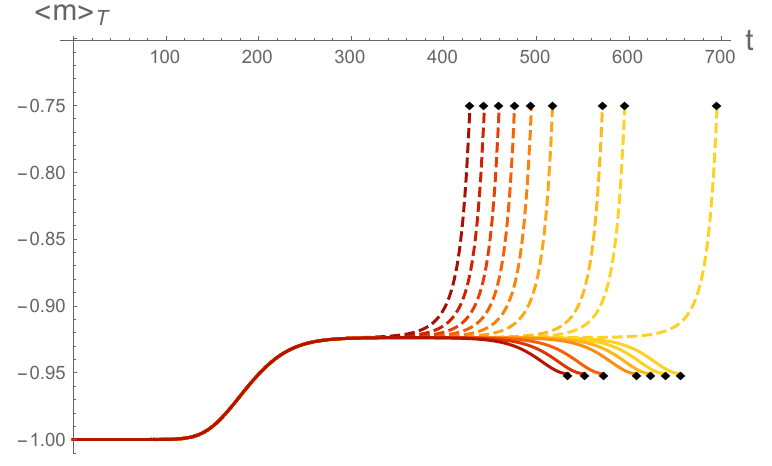
Figure 13 . Build-up processes leading to gravitational collapse (dashed) and a TMS (solid). Dashed simulations are only plotted until h m i